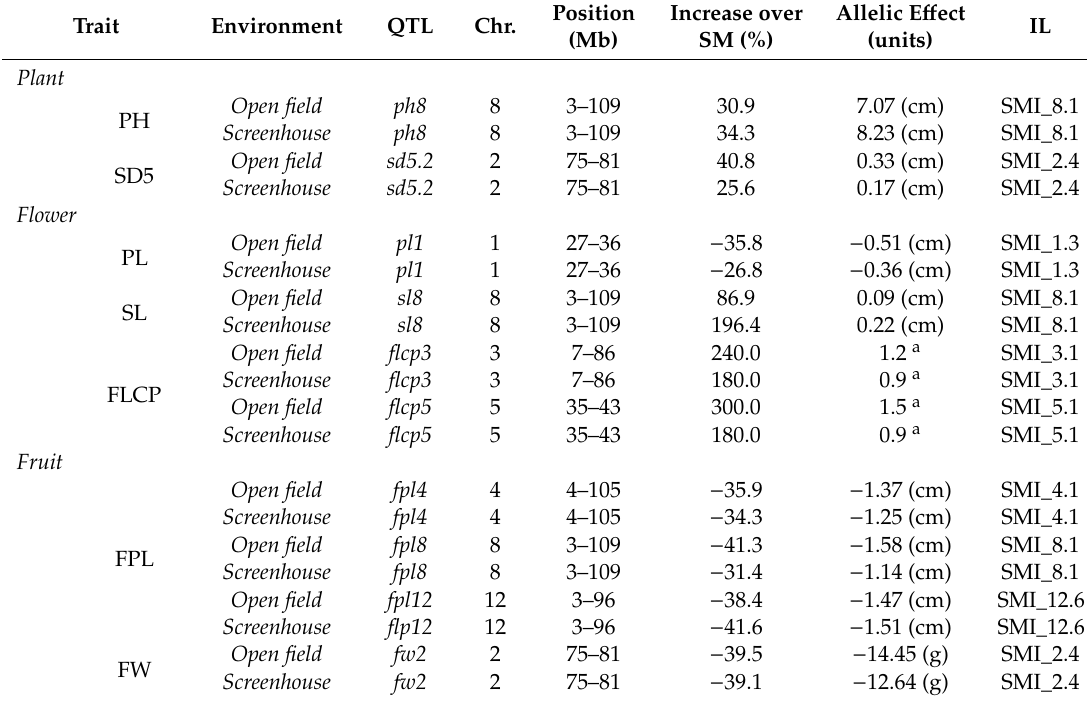
Table 5. List of putative QTLs detected in the IL